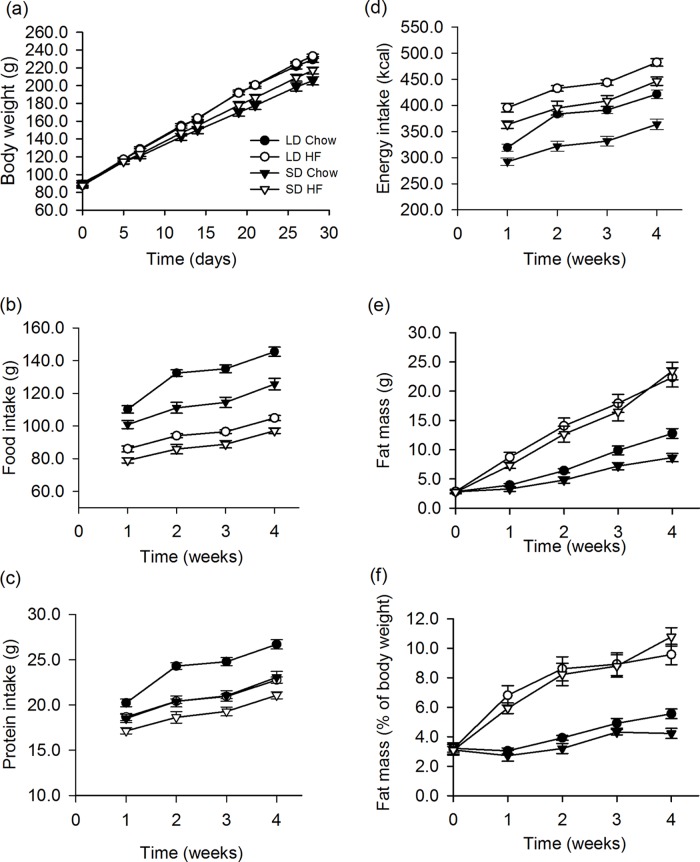
Effect of photoperiod and high fat diet (HFD) on body weight, food, protein and energy intake and body fatness of juvenile F344 rats over 4 weeks of treatment.(a) Body weight was significantly higher in LD compared to SD (p<0.001) on chow diet with no effect of a HFD after 4 weeks. (b) Food intake in grams was significantly higher in LD than SD on chow diet (p<0.001) and these intakes were higher than the intakes of the HFD fed rats (p<0.001). There was a small photoperiodic difference in food intake when fed the HFD (p = 0.03). (c) Protein intake was higher in the LD than the SD chow fed rats (p<0.001). HFD fed rats showed lower protein intakes than the chow fed rats (LD; p<0.001, SD; p = 0.008) and there was a significant effect of photoperiod (p = 0.015). (d) Energy intakes were higher in LD than SD rats fed either chow (p<0.001) or HFD (p = 0.004), while rats fed the HFD had higher energy intakes than chow in both photoperiods (p<0.001). (e) Fat mass measured by Echo MRI was slightly higher in LD than SD rats on chow (p = 0.026), while the HFD fed rats did not differ in their intakes with photoperiod. The HFD fed rats had markedly higher fat masses that were significantly higher than chow fed rats (p<0.001). (f) A HFD markedly increased adiposity as a percentage of body weight compared to chow fed rats and to a similar level in rats on both LD and SD (p<0.001) with no effect of photoperiod. In all figures HF refers to HFD fed rats.